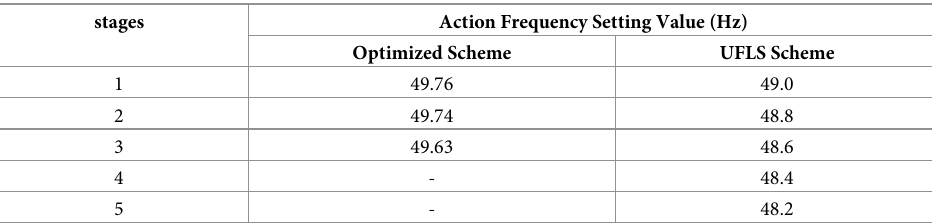
Table 2. Two comparison